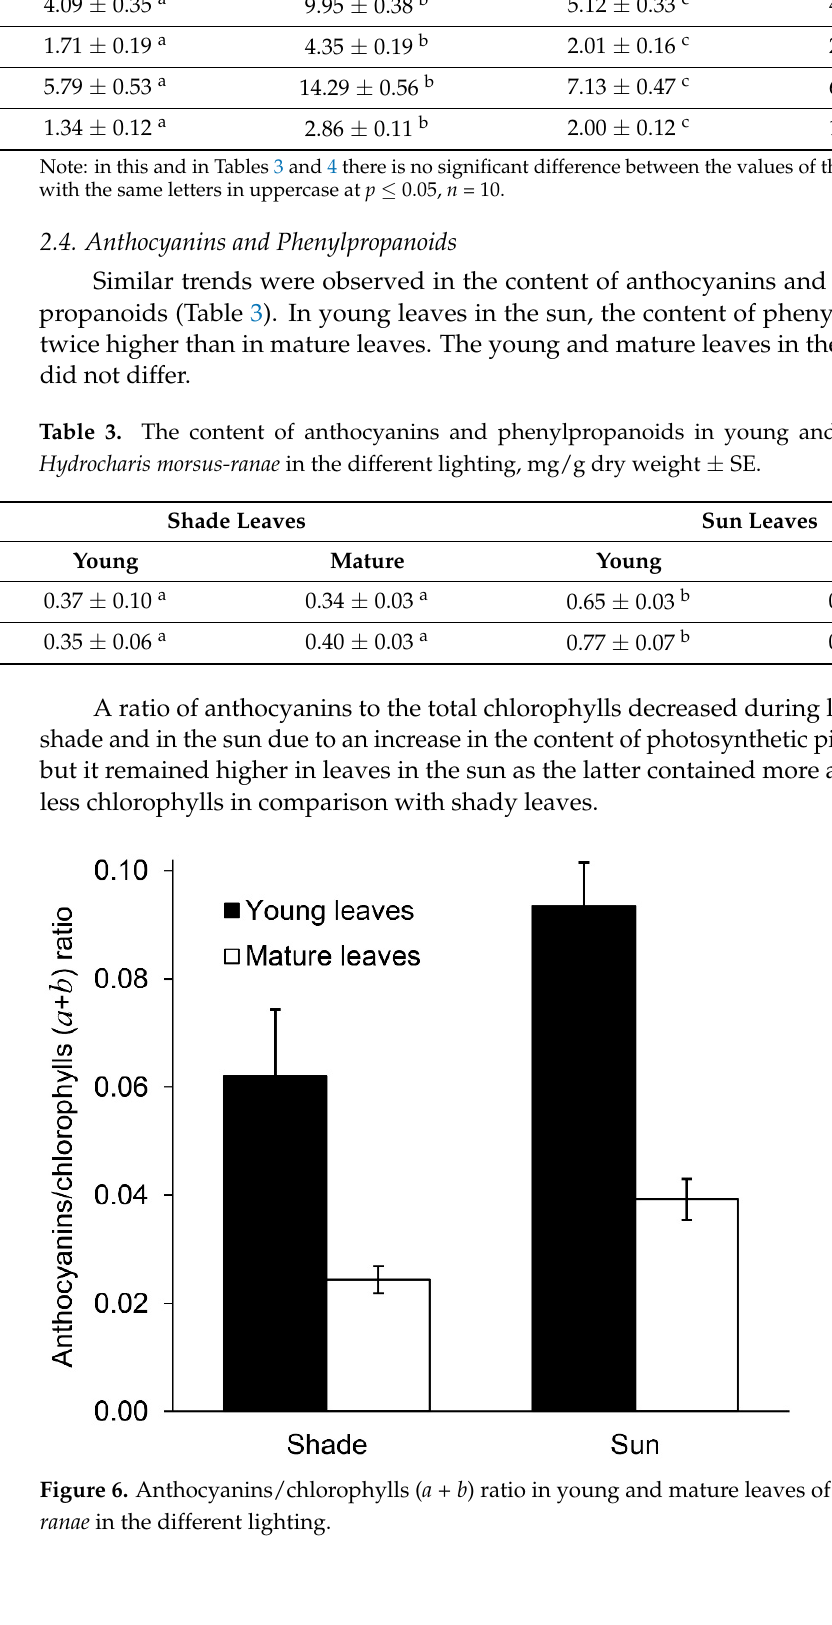
Table 2. The content of photosynthetic pigments in young and mature leaves of Hydrocharis